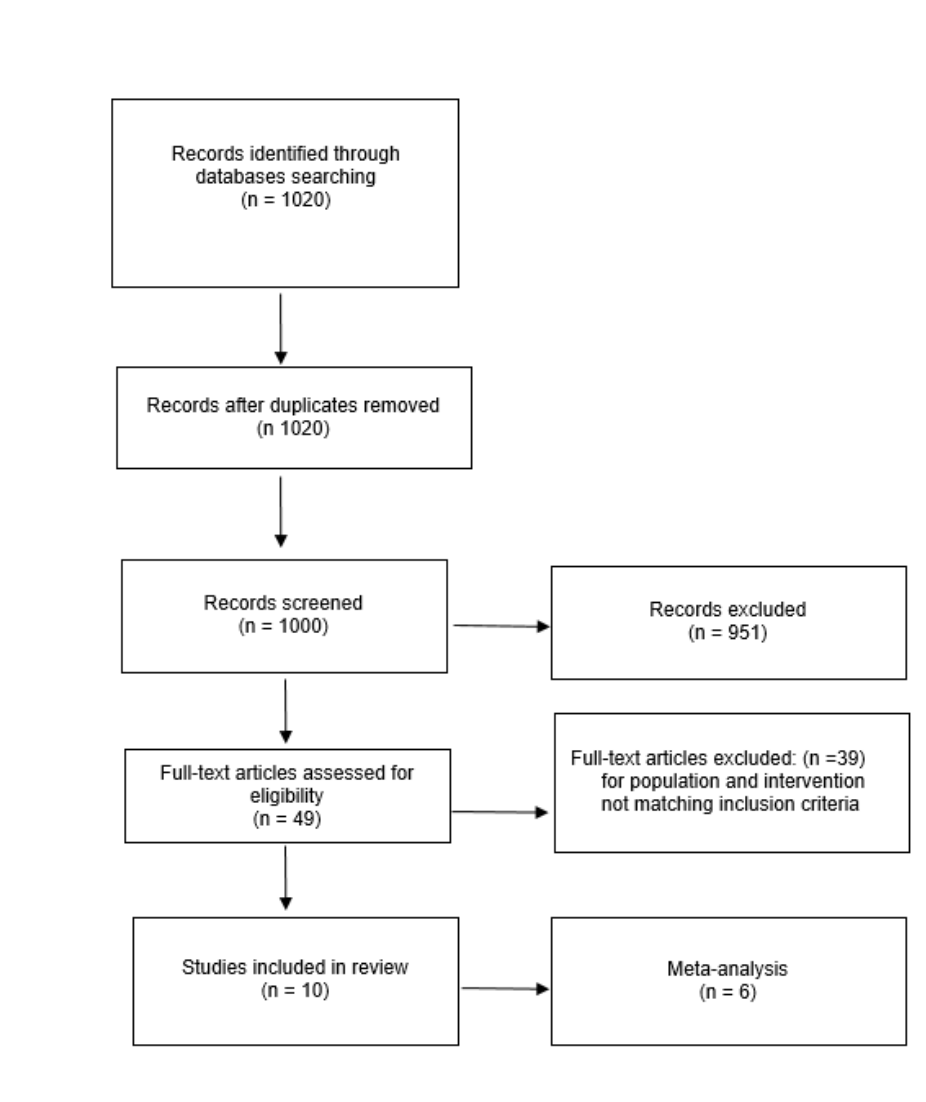
Figure 1. PRISMA flow diagram.